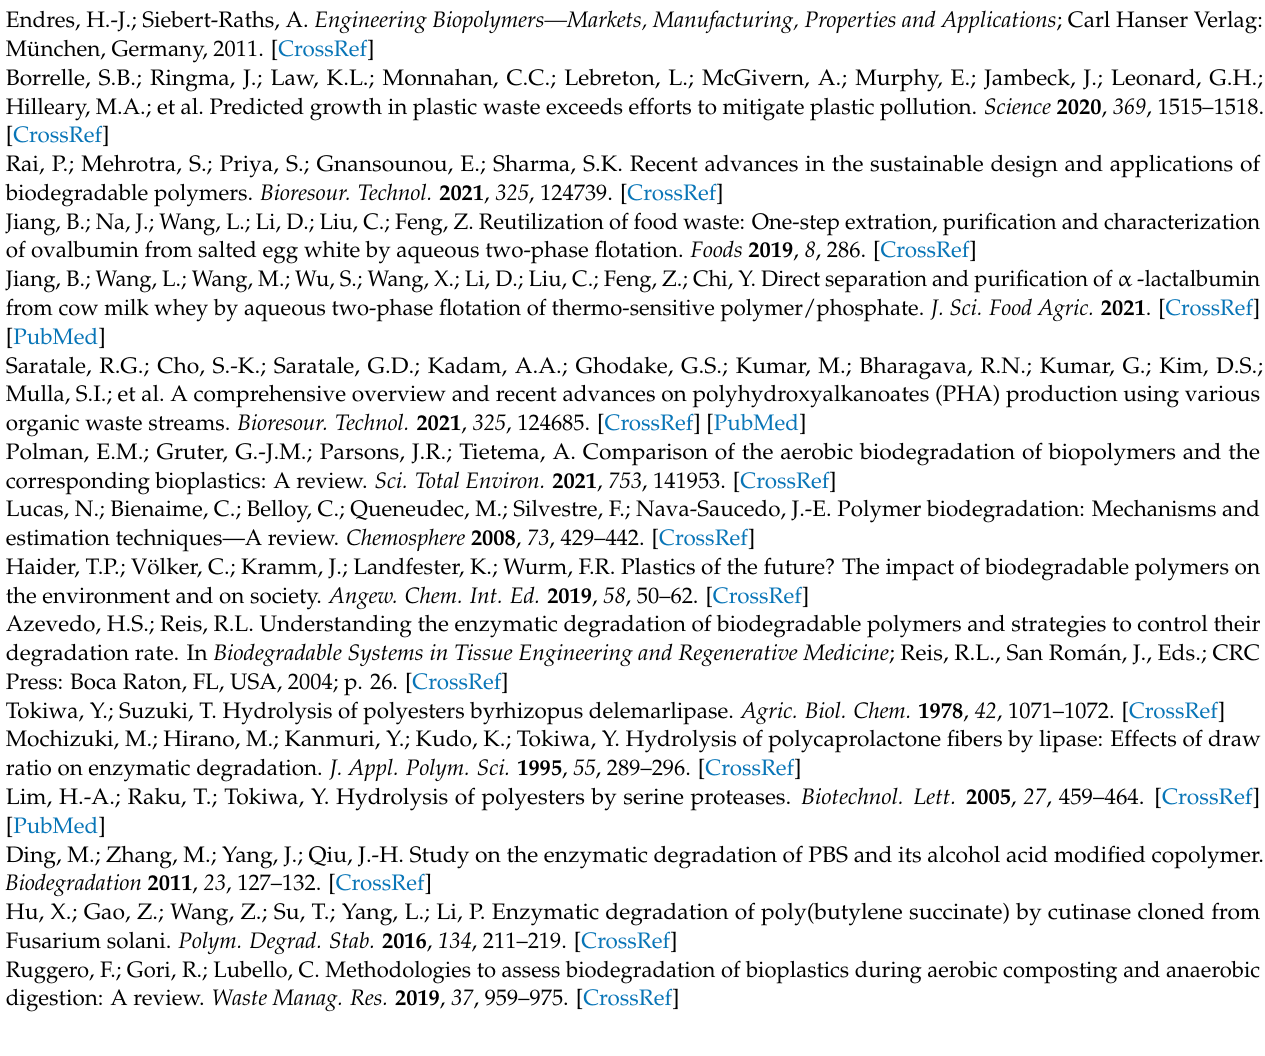
Figure S2: Fluorometric assay of PLA degradation products, Table S1: Enzyme specifications, Table S2: Polymer